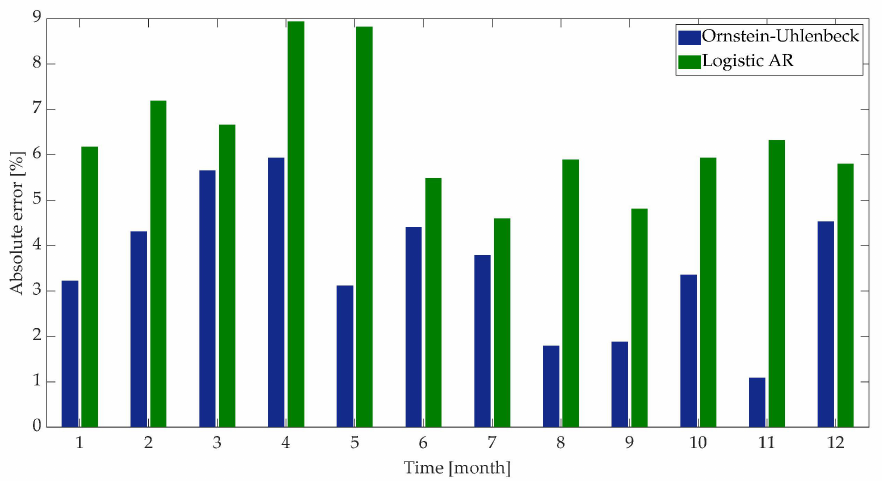
Figure 11. Errors of the second moments evaluated with characterization by logistic–AR and Ornstein– Uhlenbeck processes.